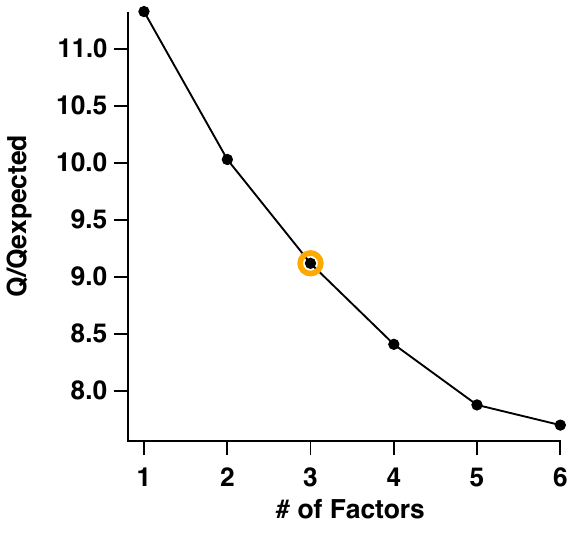
Fig.A1. Q/Q exp valuesforvaryingnumberoffactors( p values). Thecircledmarkeristhepresentedsolution. Fig. A1. Q/Q exp values for varying number of factors ( p values). The circled marker is the presented solution.